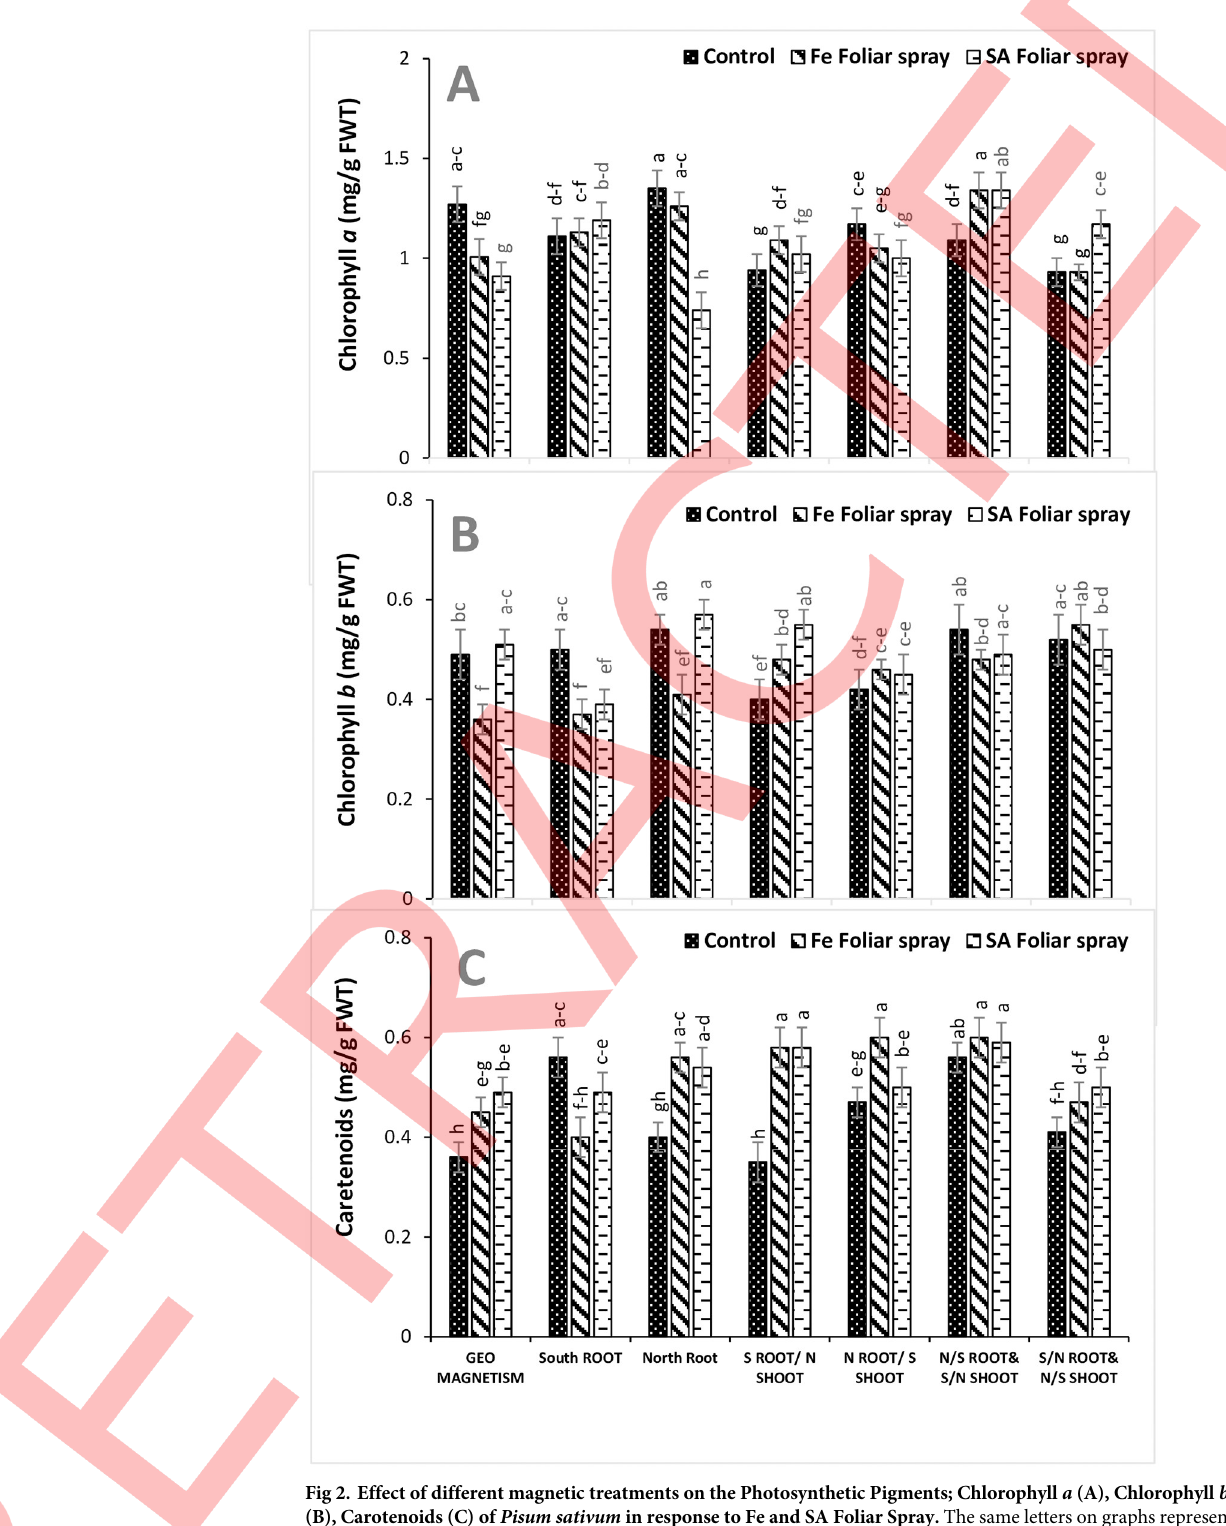
Fig 2. Effect of different magnetic treatments on the Photosynthetic Pigments; Chlorophyll a (A), Chlorophyll b (B), Carotenoids (C) of Pisum sativum in response to Fe and SA Foliar Spray. The same letters on graphs represent statistically similar effect (P <